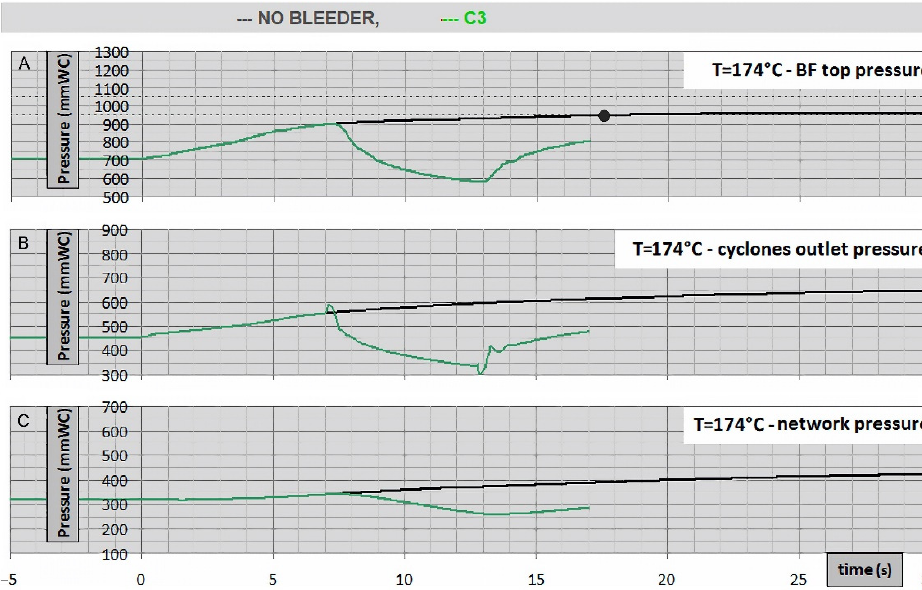
Figure 16. Evolution over time of pressure in circuit C3 compared with the no bleeders case in a low severity event. A: BF top pressure; B: cyclones outlet pressure; C: network pressure.